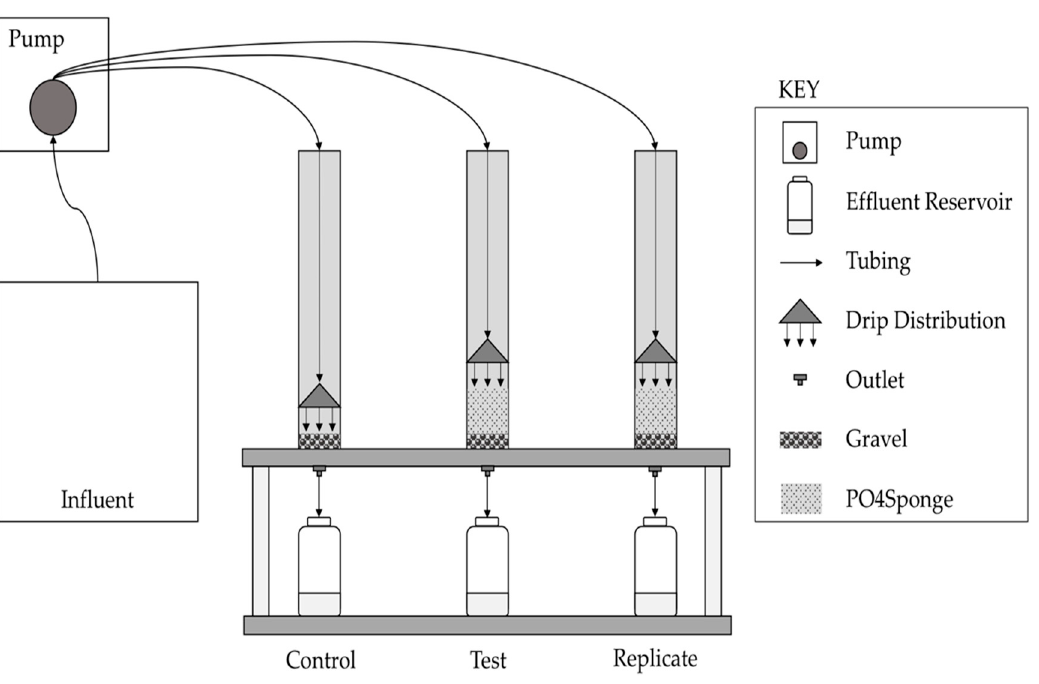
Figure 2. Phosphorus removal experimental design.